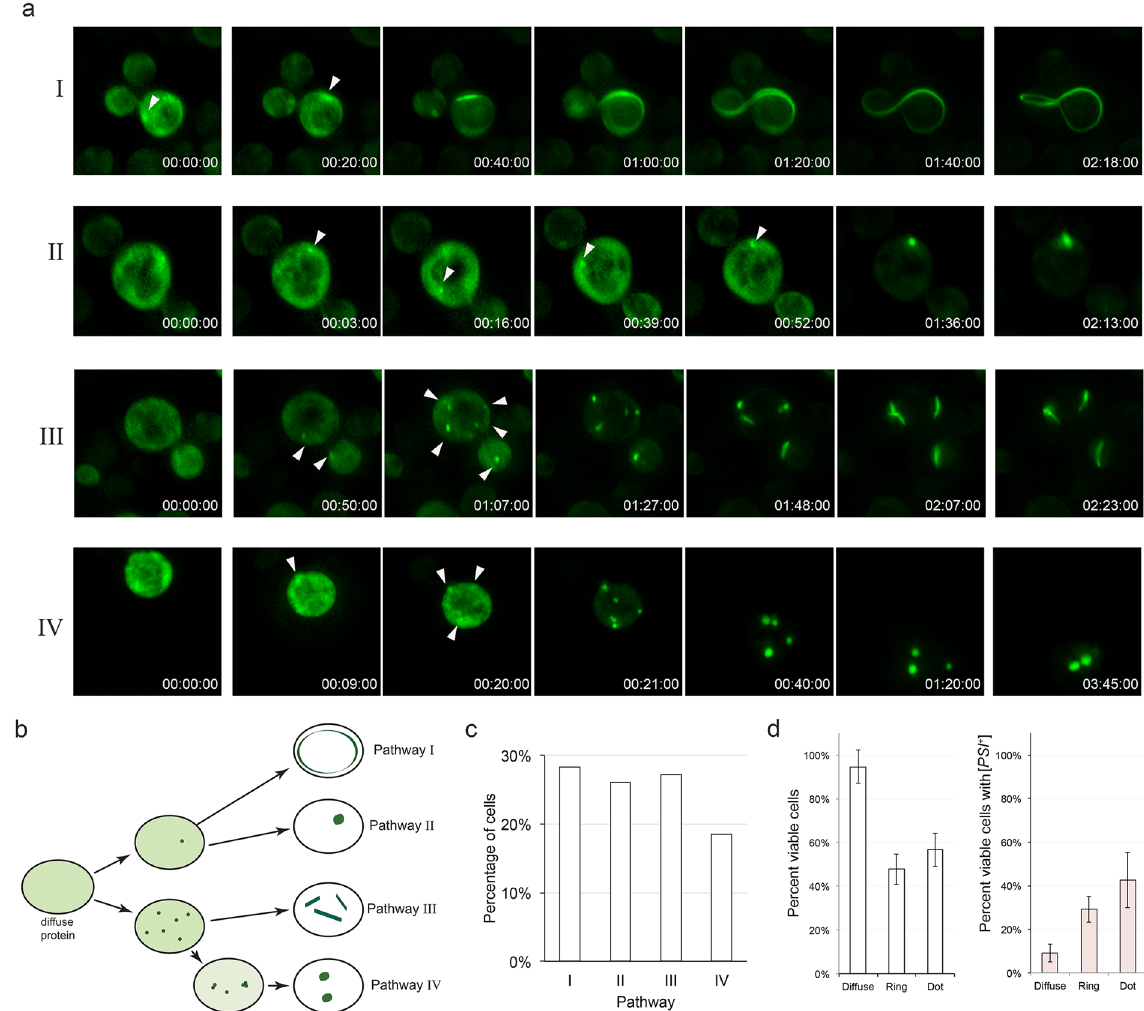
Figure 2. 4D live cell fluorescent imaging indicates that there are four major pathways to fluorescent structures. ( a ) Diffuse cells were imaged over time after 18 hours of Sup35PrD-GFP overexpression. Representative images of four distinct pathways are shown: (I) a single focus developing into a ring, (II) a single focus developing into a dot, (III) multiple foci developing into multiple lines, and (IV) multiple foci developing into multiple dots. The time indicated is relative to foci appearance in HH:MM:SS. Arrowheads indicate the emergence of an early focus or foci. ( b ) Diagrammatic representation of the four pathways. ( c ) Ninety-two time-lapsed cells were categorized into the four pathways. Statistical analysis using the Kolmogorov Smirnov (KS) test indicated that there is no preference in pathway. ( d ) Diffuse, ring, or dot containing cells were isolated by micromanipulation and placed on rich media. Viable cells were assayed for microcolony growth on agar slabs placed on rich media (left panel). Viable colonies were streaked on rich media to assay for the presence of [ PSI + ]. Standard deviation is